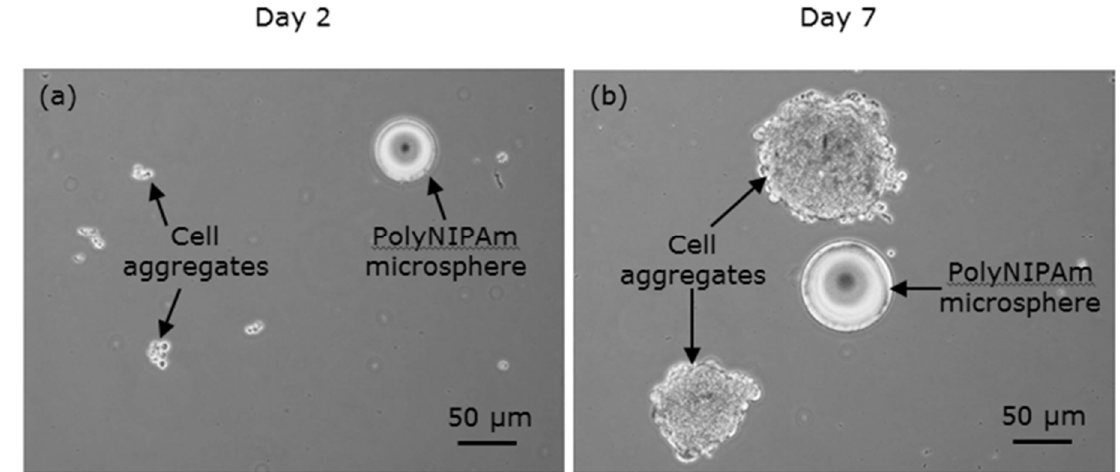
Figure 11. Optical micrographs of HEK cells suspension containing polyNIPAm microspheres synthesized using redox initiators (R1), on ( a ) Day 2 and ( b ) Day 7 of the culturing process.